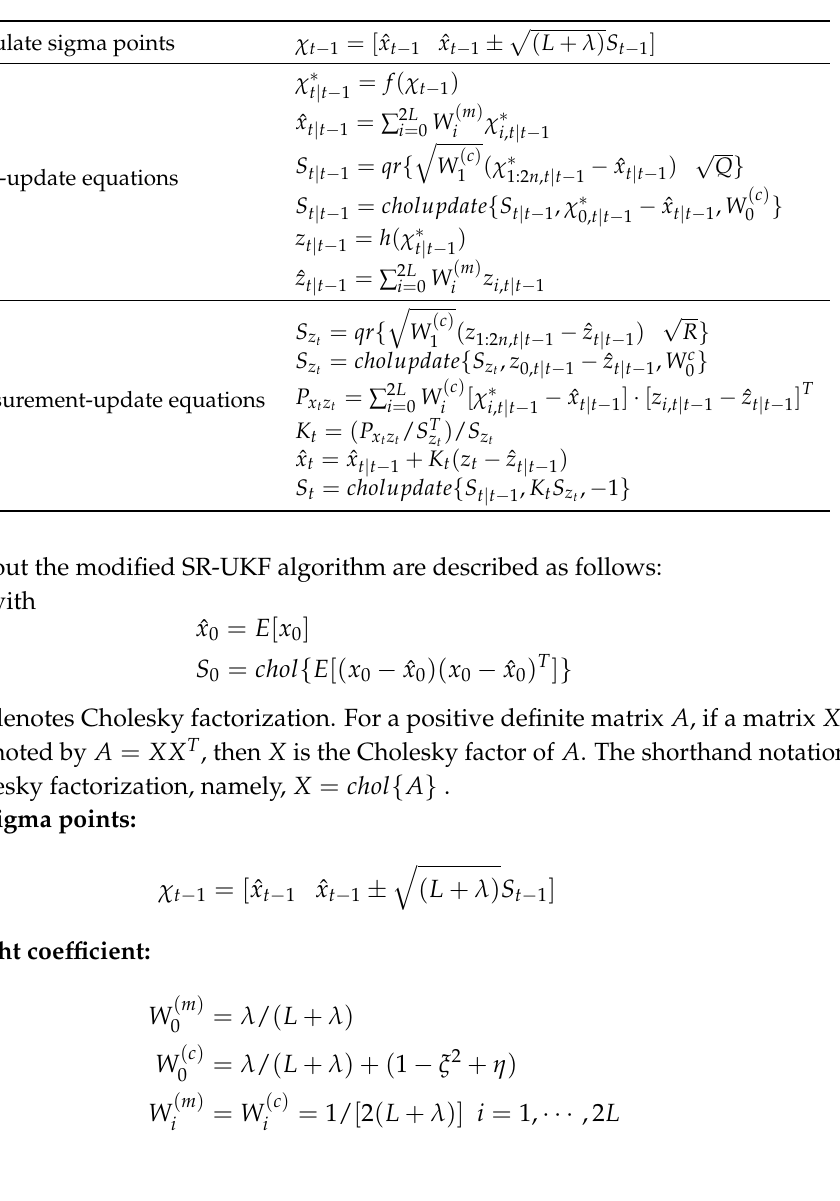
Table 2. Square-root unscented Kalman